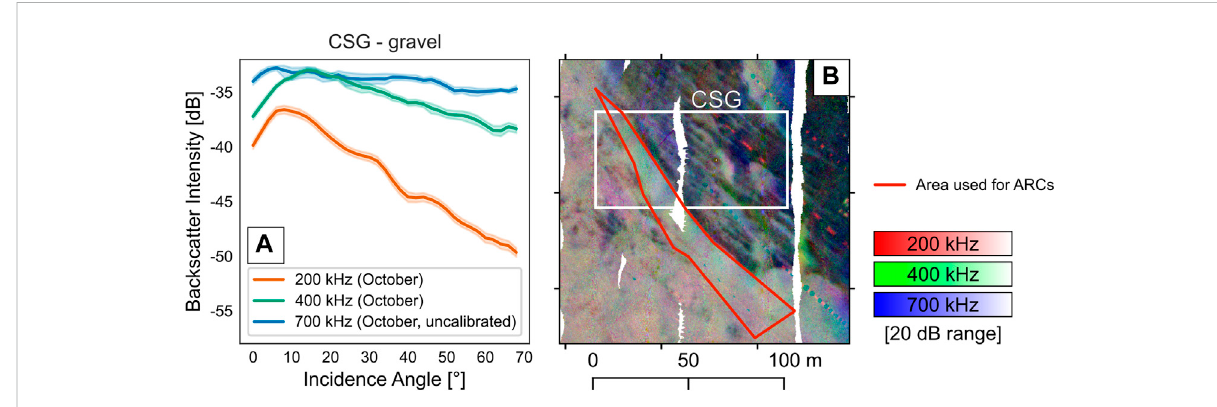
FIGURE 10 (A) Angular range curves (ARCs) at 200, 400, and 700 kHz frequency (October) for a gravelly area within the CSG facies. A 95%-con fi dence interval was added to the curves. The uncalibrated backscatter values of the 700 kHz frequency allow only for a relative comparison. (B) Exact area used for the ARCs is outlined in red. The multifrequency backscatter map (200, 400, and 700 kHz) in the background shows the transition from the reef to CSG facies in October. The NW-SE orientated ripple occurring in October is prominently visible as bright bluish colors surrounded by dark